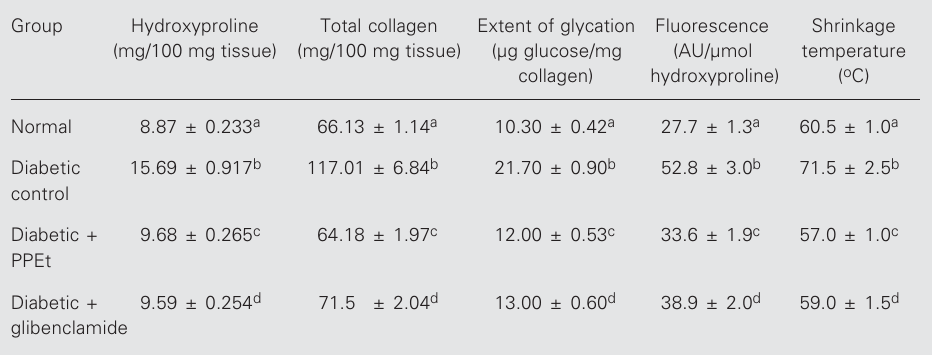
For drug administration see Table 1 legend. AU = arbitrary units. Data are reported as means ± SD for 6 rats in each group. Values not sharing a common superscript letter differ significantly at P < 0.05 (Duncan multiple range test).